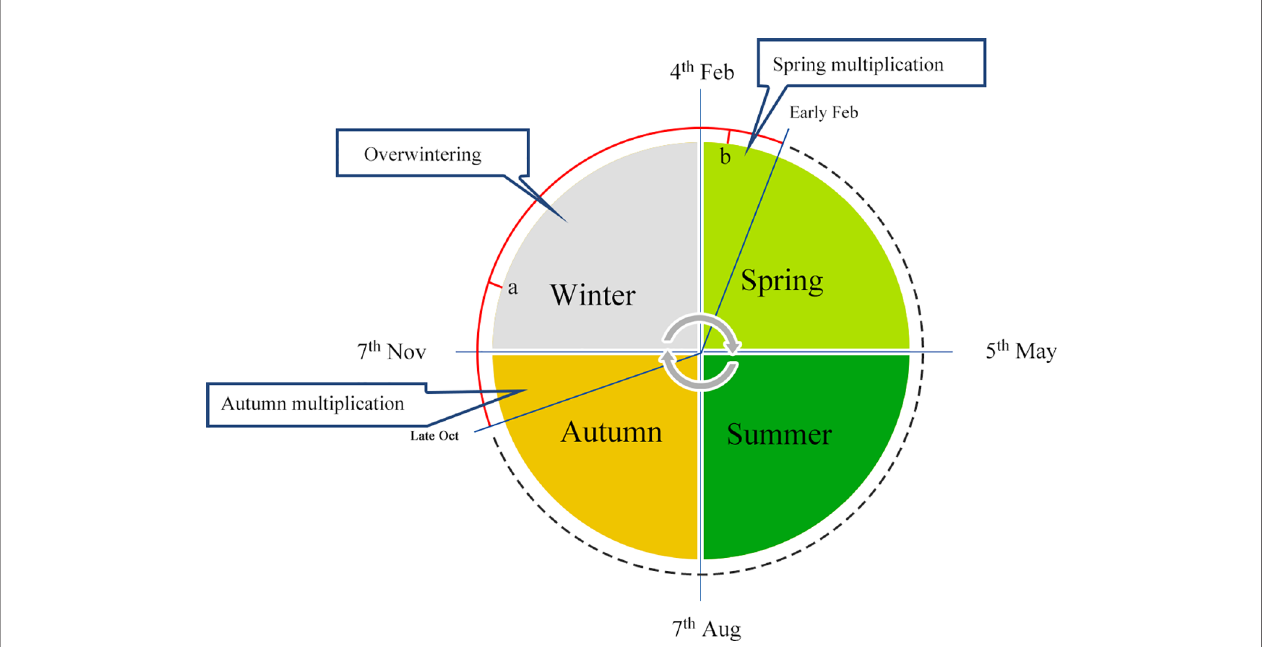
FIGURE 1 | Annual schedule of overwintering management. Honeybee overwintering typically occurs from October to the following March, and samples collected at points a and b represent winter and spring bees,